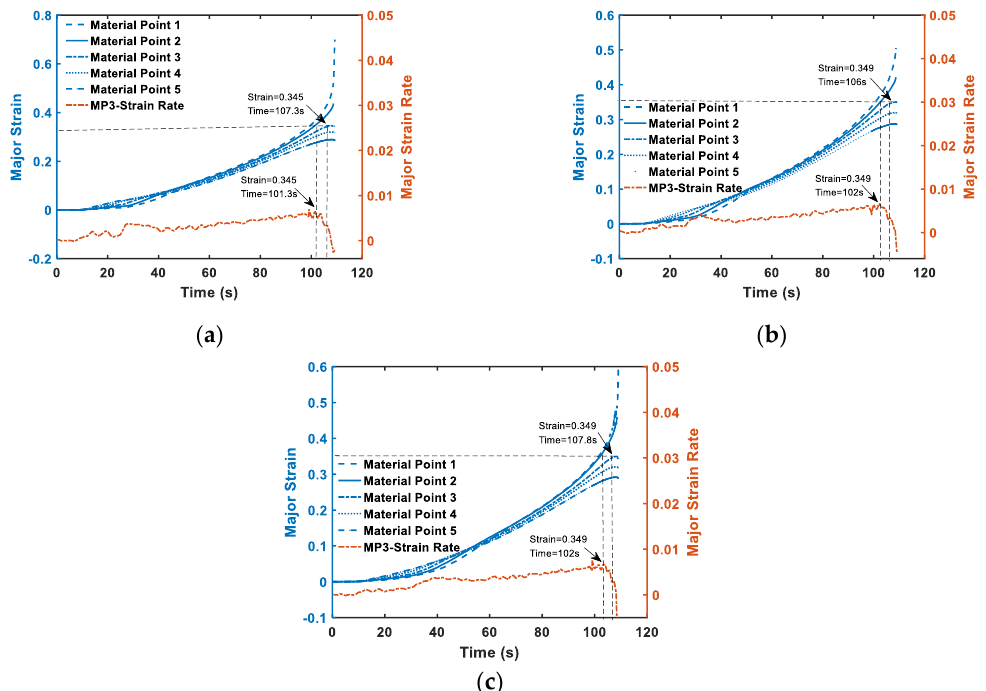
Figure 8. Major strain and strain rate evolution for the second test: ( a ) section a; ( b ) section b; ( c ) section c.